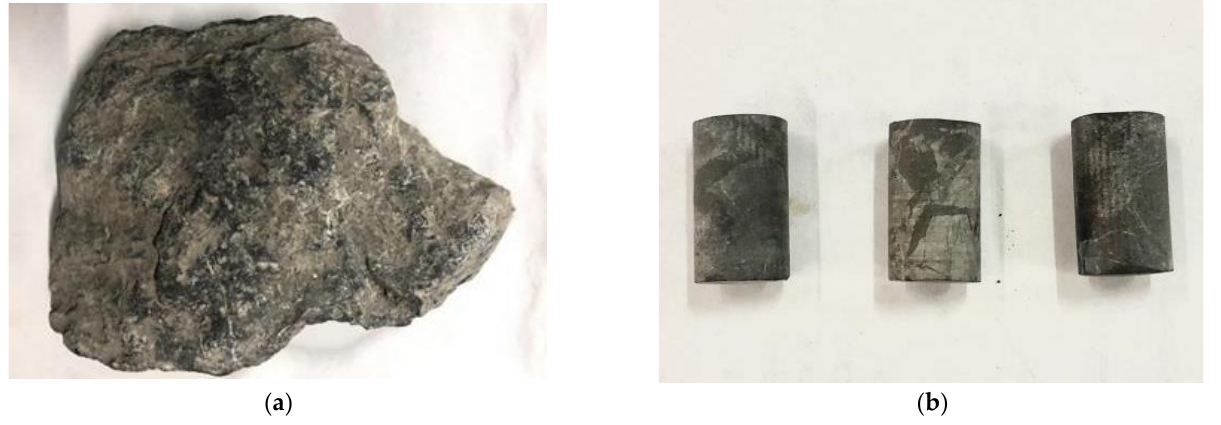
Figure 6. Limestone sample: ( a ) limestone parent rock; ( b ) limestone cylinder test piece. Table 2. Diameters, heights, and quality of limestone cylinders.